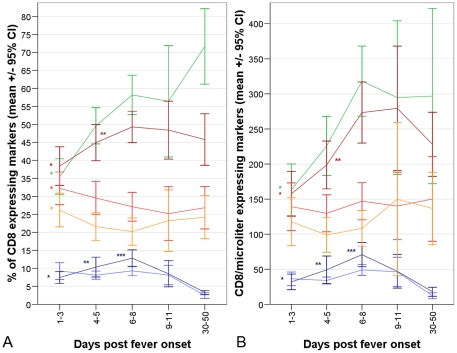
Activation, differentiation and extravasation marker expression by CD8 T cells over the course of mild influenza A illness.The percentages (a) and absolute count (b) of CD8 T cells with the phenotypes CXCR3high (green lines); CD27+CD28+ (brown lines); CD27+CD28−(red lines); CD27−CD28− (yellow lines); CD38+HLA-DR- (light blue lines) and CD38+HLADR+ (dark blue lines) is shown for 39 patients with mild influenza illness at different time intervals post-fever onset. The number tested during each time interval was 28, 34, 39, 19 and 9. Asterisks indicate where values differ significantly via paired t-Test from levels at recovery (*), or at recovery and day 1–3 (**), or at recovery and at earlier time intervals (***).